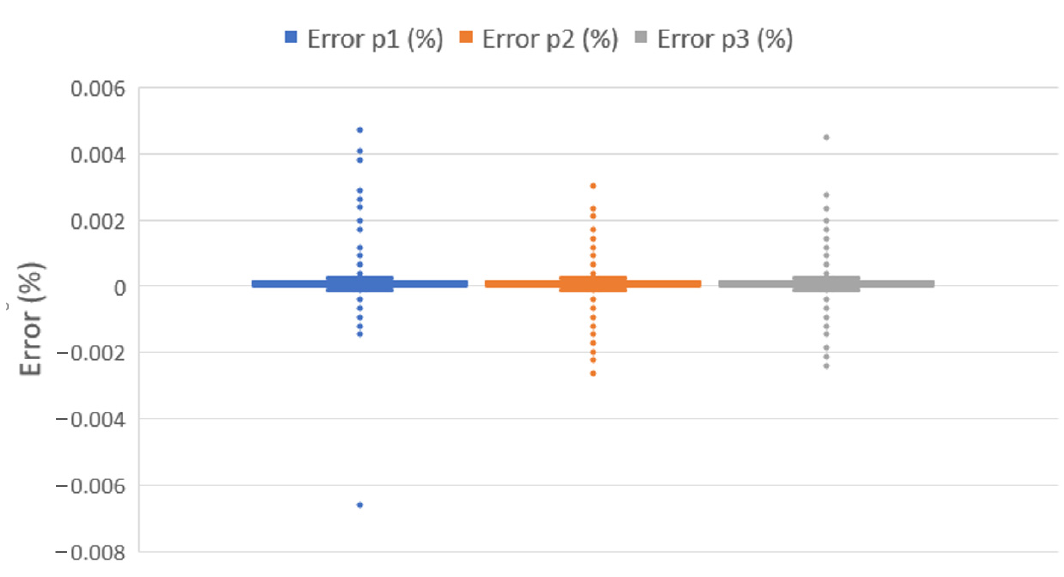
Figure 4. Errors calculated at Circuit 5 feeder’s head, yearly simulation, four zones; p1, p2, and p3 are the phases.